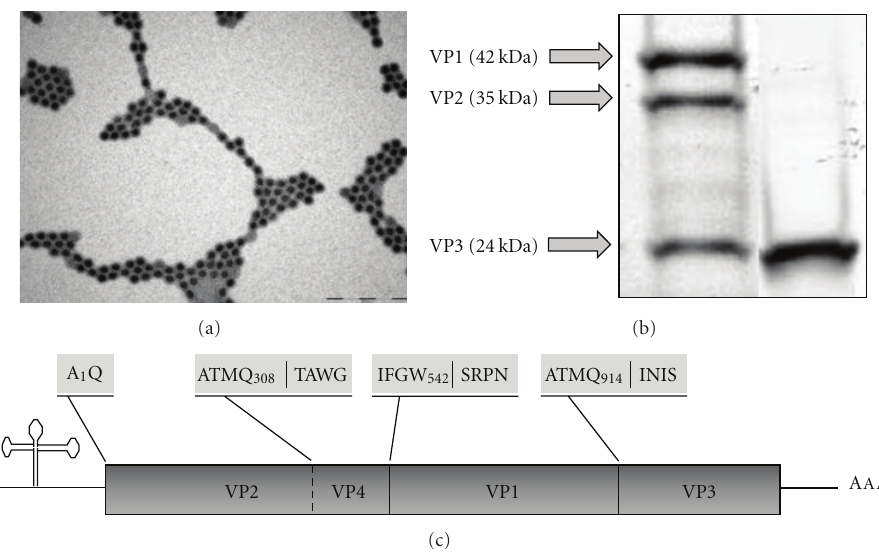
Figure 3: (a) Electron micrograph of purified SINV-1 particles. Scale bar represents 200nm. (b) SINV-1 capsid proteins separated by SDS-PAGE (lane 1) and probed with polyclonal antibodies developed toward a portion of the predicted capsid protein, VP3 (lane 2). (c) Illustration of the intergenic region, IRES, and ORF 2 of SINV-1. Scissile bonds of each capsid protein of ORF 2 as determined by N-terminal sequence analysis of VP1, VP2, and VP3. Cleavage positions (subscript numeral) and amino acid residues about the cleavage site (vertical line) are